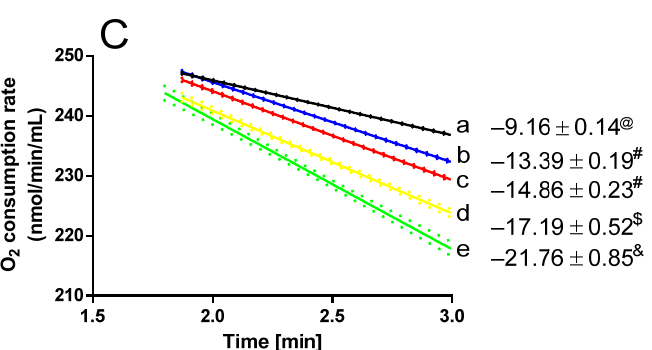
Figure 5. ( A ) Gos stimulates Fe(II) autoxidation in the absence of rat brain mitochondria in a standard medium supplemented with 1 mM citrate, and 5 mM 1,10-phenanthroline. 1,10-phenanthroline was added 1 or 5 min after the Gos–Fe(II) incubation period, and the absorbances were read at 510 nm. Values are the average of three determinations. * statistical difference at p < 0.05 when comparing 1 vs. 5 min incubation. ( B ) Effects of Gos on O 2 consumption mediated Fe(II) autoxidation in a standard medium supplemented with 1 mM citrate under the following conditions: ( a ) No Gos, (b) 10 µM Gos, (c) 30 µM Gos, (d) 50 µM Gos, and (e) 100 µM Gos. Fe(II) (50 µM) was added where indicated by the arrow. Results are representative of three experiments. ( C ) Oxygen consumption rate (nmol O 2 /min/mL) 1 min after Fe(II) addition. Legends are the same as in ( B ). Different symbols indicate statistical differences at p < 0.05 when comparing all pairs of experimental groups (in the same cell type) according to the ANOVA and post hoc Newman-Keuls tests. (If the symbols are different among groups indicate statistical differences, when they are equal, there is not.)